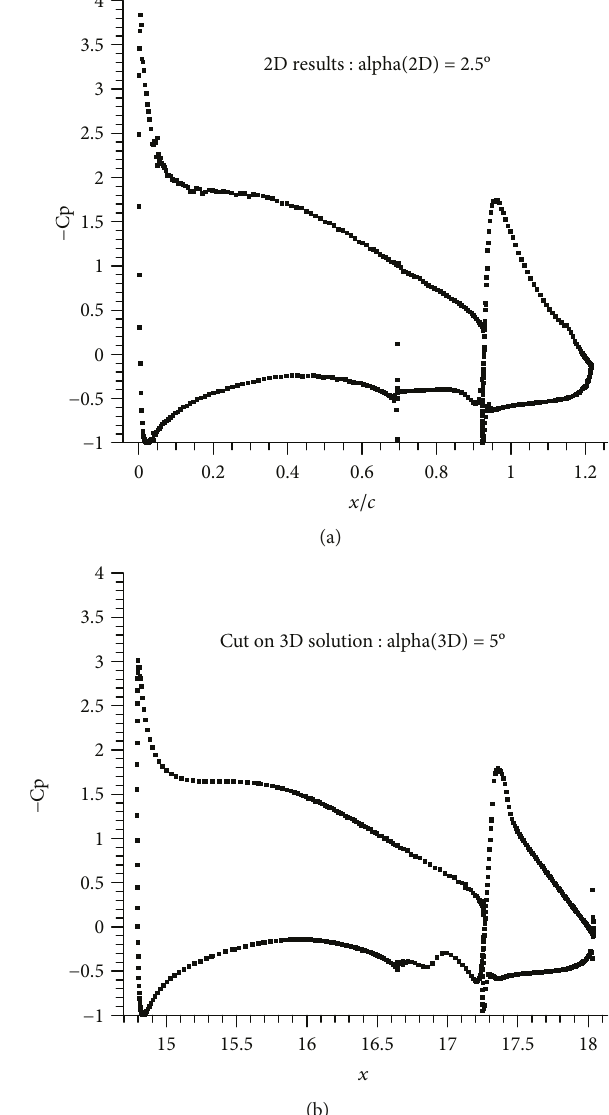
Figure 28: Comparison of Cp distributions between 2D and 3D (no DN – takeo ff